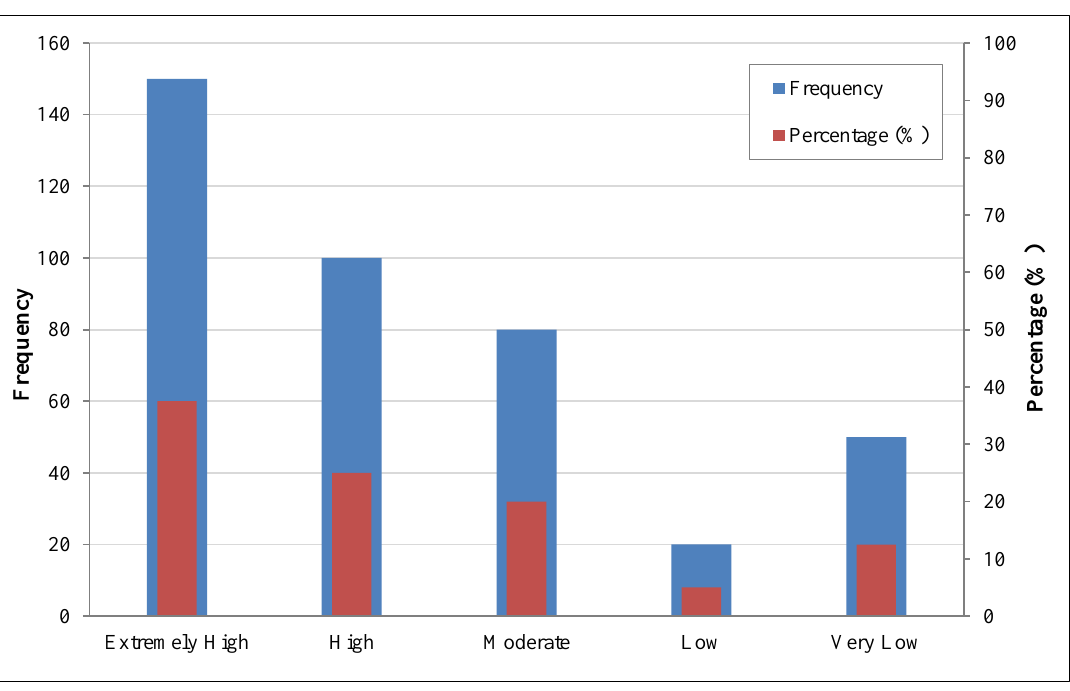
Figure 1. Showing Level of Utilization of Oil Palm